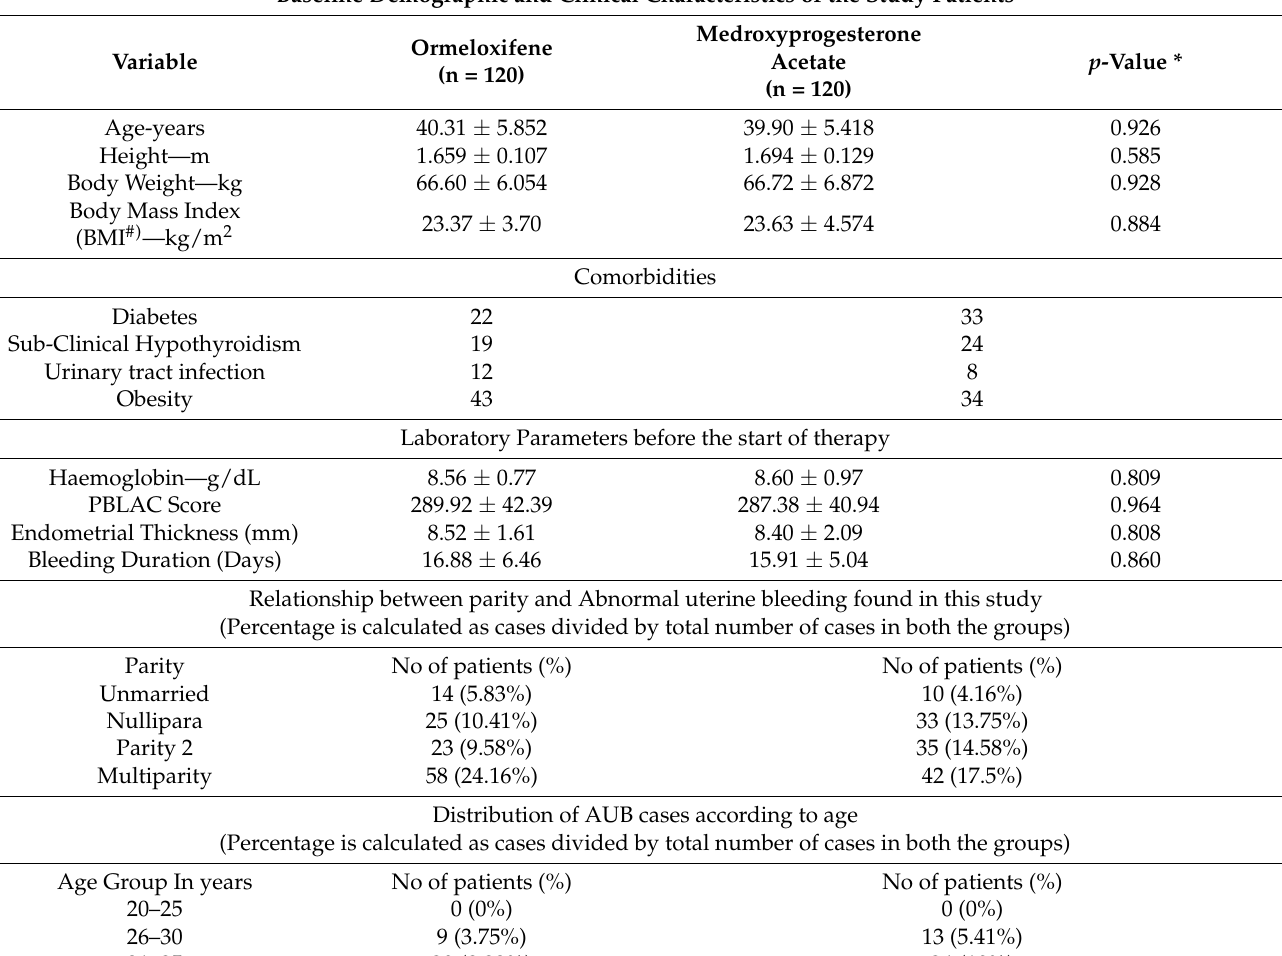
Table 2. Baseline clinical and laboratory characteristics at the time of enrolment. Demographic data like age, body mass index, and other parameters were comparable among